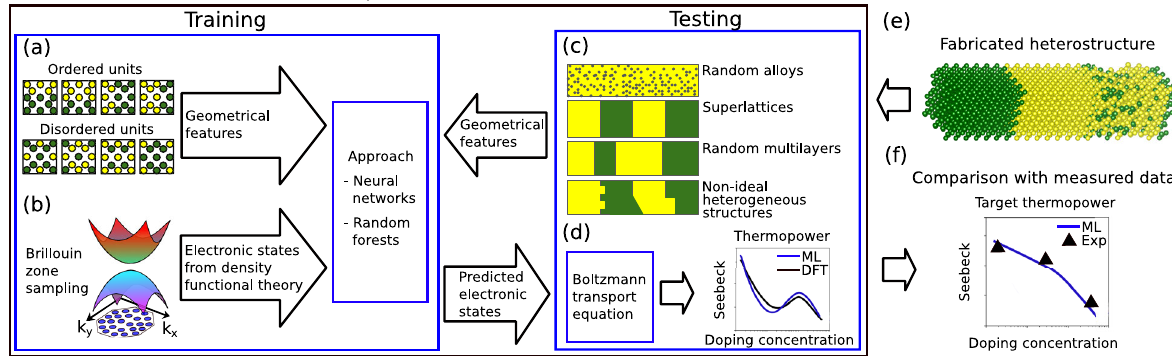
Fig. 1 Outline of framework to predict electronic properties of heterostructures. a Ordered and disordered 16-atom fragment units of varied compositions. Features describing local atomic con fi gurations, CN ( r ), of these units are used to train ML algorithms. b Property value corresponding to features: energy bands, E ( k , b ), computed with DFT, where b is band index and k -points sample Brillouin zones of the units. Neural networks and random forests algorithms are used to learn relationships between local con fi gurations and energy bands, f ( CN ( r ), E ( k , b )) ’ s. c Trained ML algorithms are tasked to predict ^ E ð k ; b Þ ’ s for input CN ( r ) ’ s, corresponding to larger structures of varied compositions. Predicted ^ E ð k ; b Þ ’ s are validated against DFT-computed effective band structures 51,52 . d Thermopower or Seebeck coef fi cients ( S ) are calculated using semi-classical Boltzmann transport equation (BTE). Cross-validation is carried out by comparing S calculated from ^ E ð k ; b Þ and direct DFT results. e Representative con fi guration of a fabricated heterostructure. Target S of fabricated heterostructures are computed from ^ E ð k ; b Þ using BTE, and f compared with measured